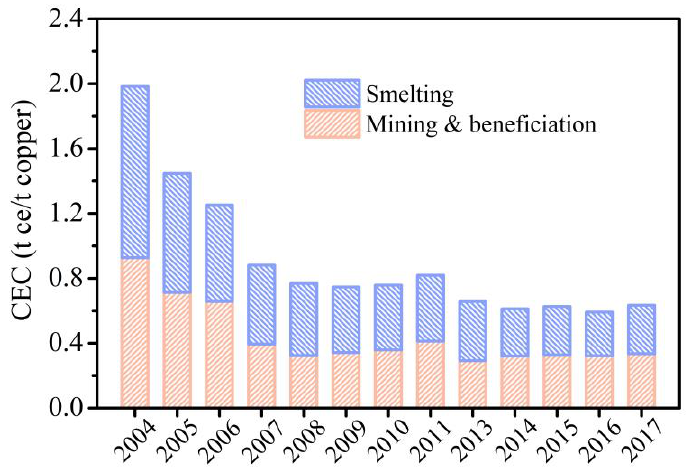
Figure 2. The CEC of copper production during 2004 – 2017.